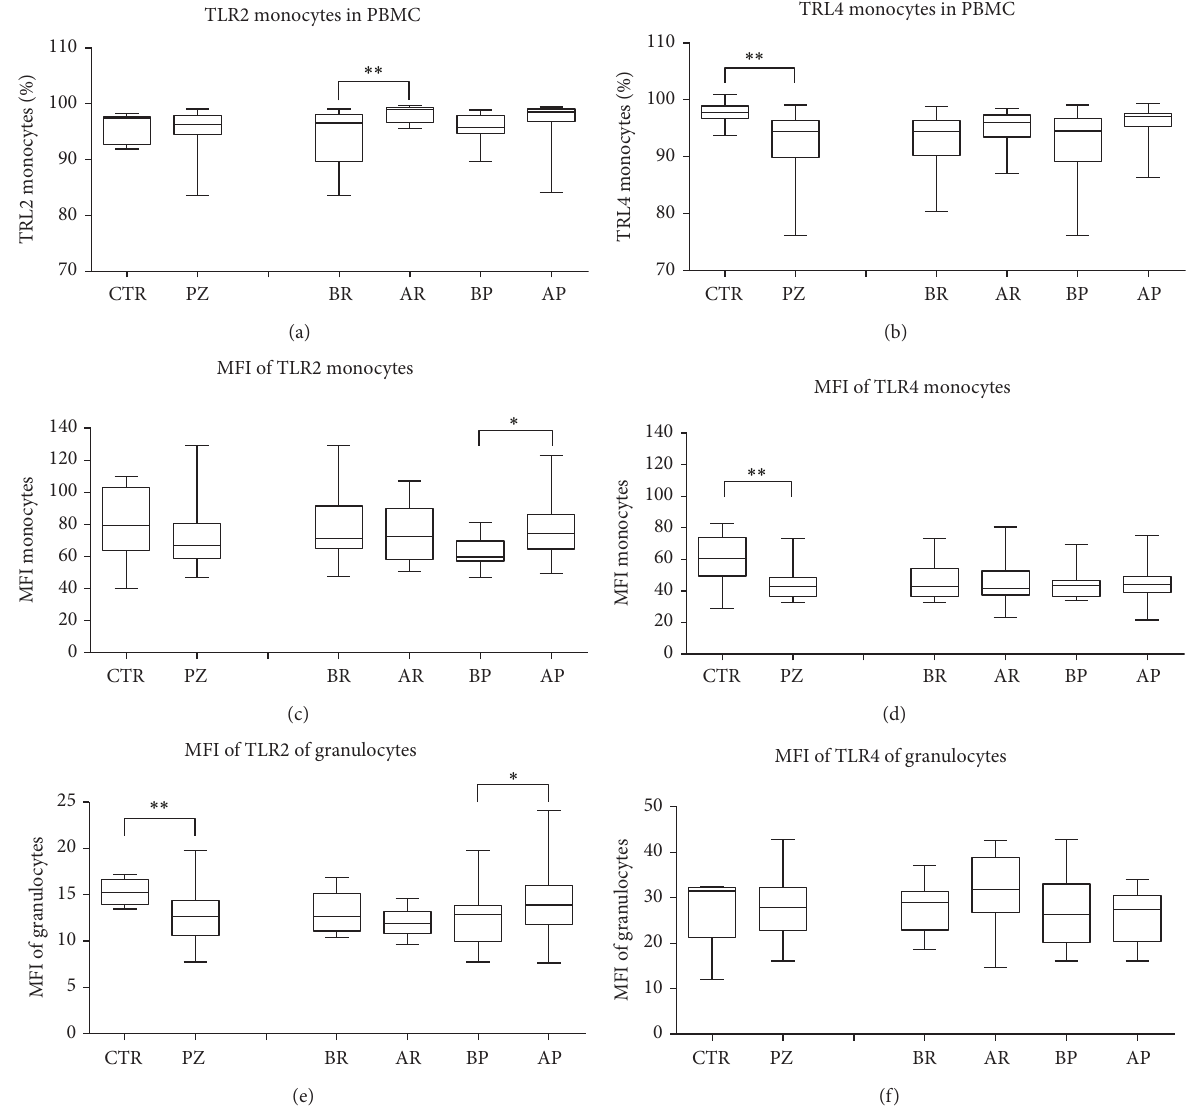
Figure 3: Expression of TLRs in monocytes and granulocytes. (a, b) Percentage of TLR2 and TLR4 monocytes in peripheral blood, at baseline and after Rifaximin and placebo treatments. (c, d) Median of fluorescence (MFI) of TLR2 and TLR4 monocytes in peripheral blood at baseline and after Rifaximin and placebo treatments. (e, f) MFI of TLR2 and TLR4 granulocytes in peripheral blood at baseline and after Rifaximin and placebo treatments. The values reported in box-and-whiskers plots show the minimum, the 25th percentile, the median, the 75th percentile, and the maximum. In particular, the whiskers go down to the smallest value (minimum) and up to the largest one (maximum), the top and bottom of the box are the 25th and 75th percentiles, and the line in the middle of the box is the median corresponding to 50th percentile ( ∗∗∗ 𝑃 < 0.001 , ∗∗ 𝑃 < 0.01 , and ∗ 𝑃 < 0.05 patients versus controls (health or baseline)). Healthy control (CTR), UDD patients (PZ), before Rifaximin (BR), after Rifaximin (AR), before placebo (BP), and after placebo